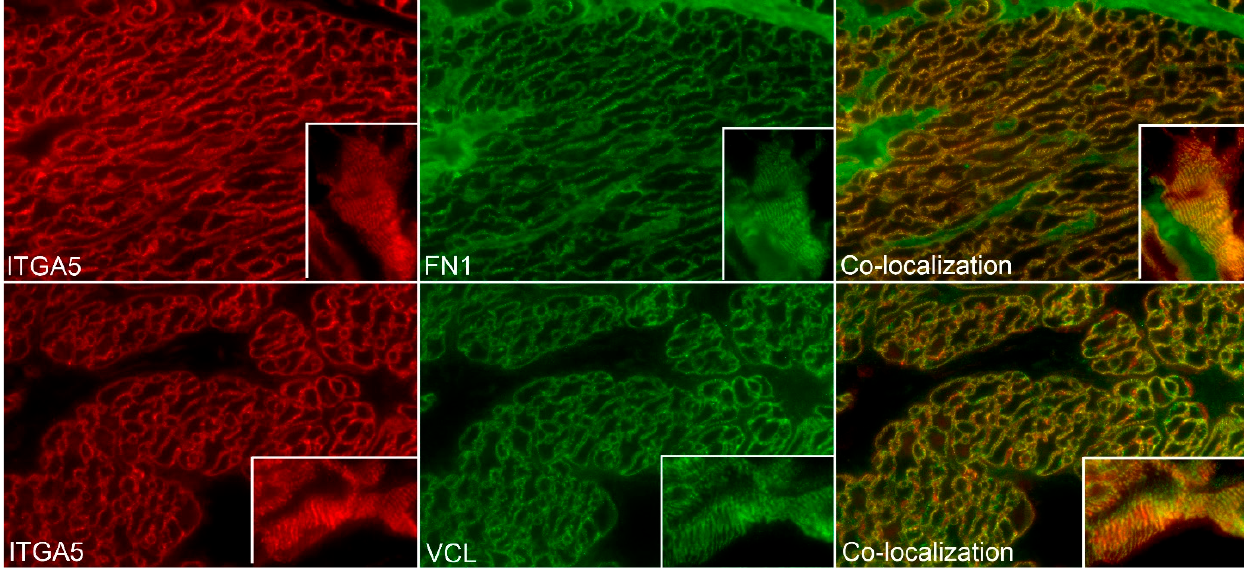
Figure 6. Assembly of integrin adhesion complexes (IACs) in sheep myometrium. Immunostaining for alpha 5 integrin (ITGA5, red color), fibronectin (FN1, green color), and vinculin (VCL, green color) in the myometrium of ewes on Day 80 of pregnancy is shown. ITGA5 and FN1, and ITGA5 and VCL co-distributed to the same regions on the surface of the myometrial cells (note), confirming the presence of IACs. Note that while ITGA5 and VCL are co-localized, VCL is located deeper within the cytoplasm therefore fluorophores do not always overlap. The width of each field is 220 µm; inserts are between 20–30 µm wide.